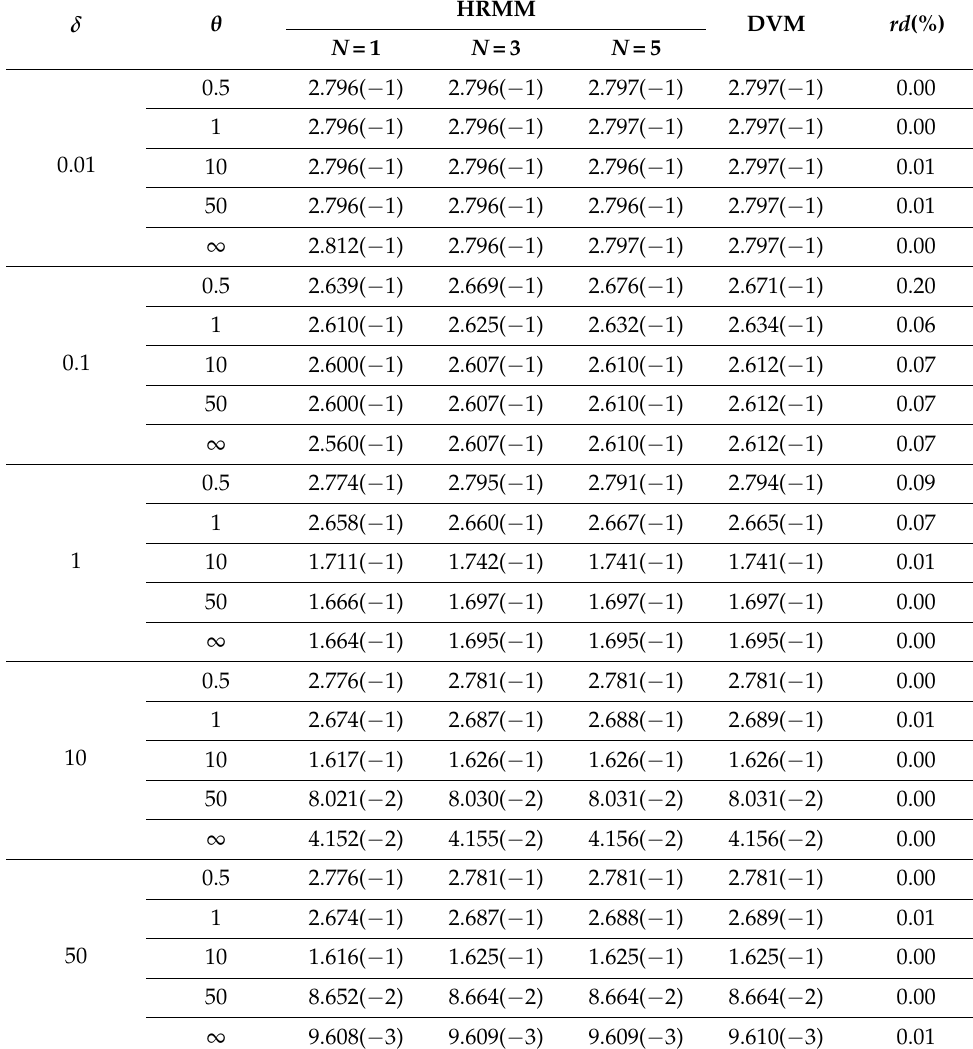
Table 4. Oscillatory Couette flow; shear stress amplitude at the oscillating wall p xy,A ( y = 0) for various values of δ and θ based on the HRMM, with N = 1,3,5 and the DVM, along with the relative difference between corresponding